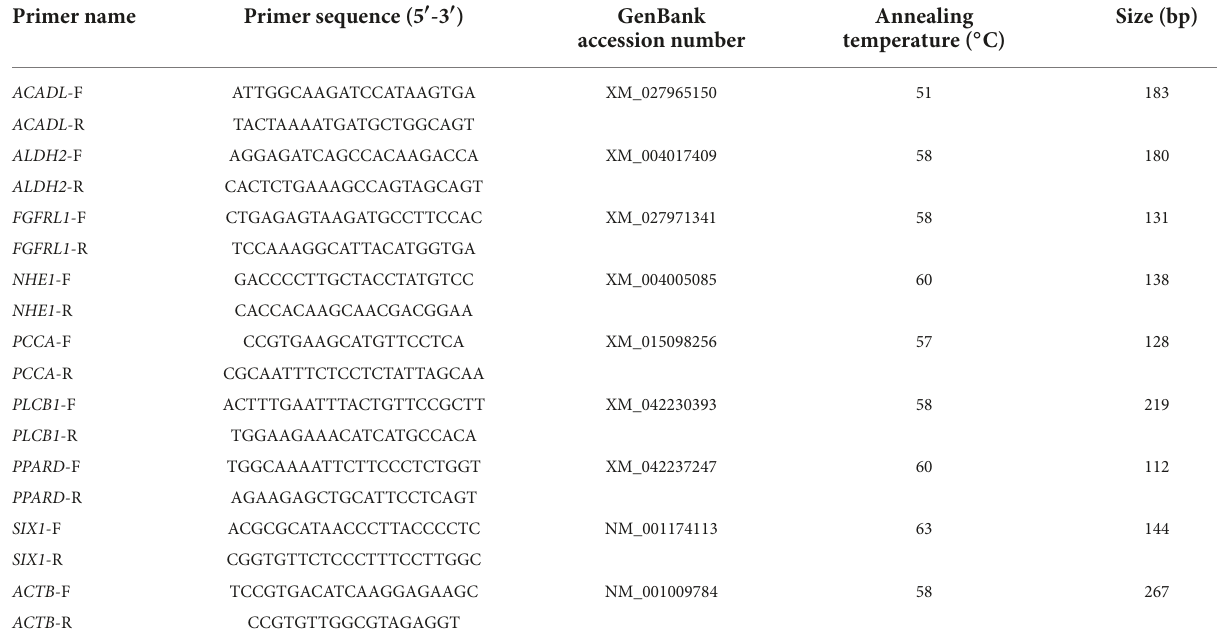
TABLE 1 Primer pairs designed for target genes.